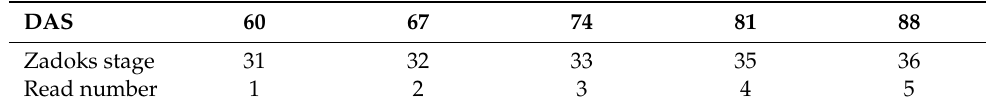
Table 1. Number of reads, plant growth stage expressed in Zadoks